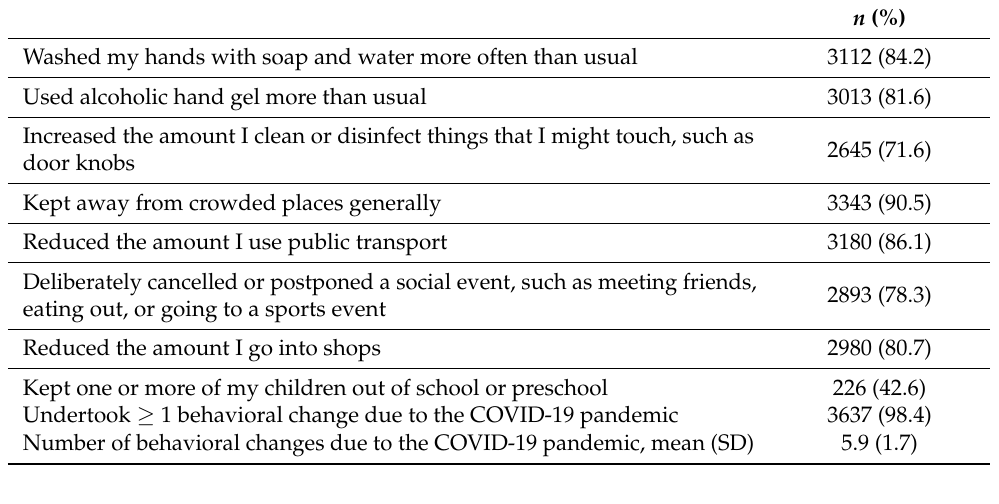
Table 3. Behavioral responses to COVID-19 pandemic.